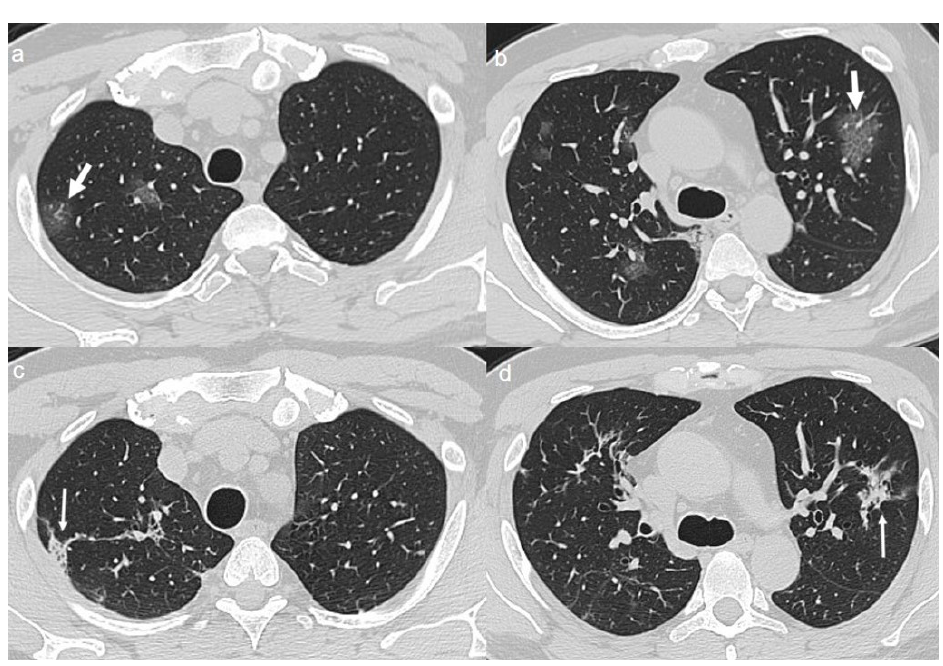
Figure 4. ( a , b ) CT shows patchy areas of GGO with in the upper lobes (arrows). ( c , d ) CT after 4 months from the onset of symptoms shows bilateral persistence of fibrotic stripes in upper lobes (thin